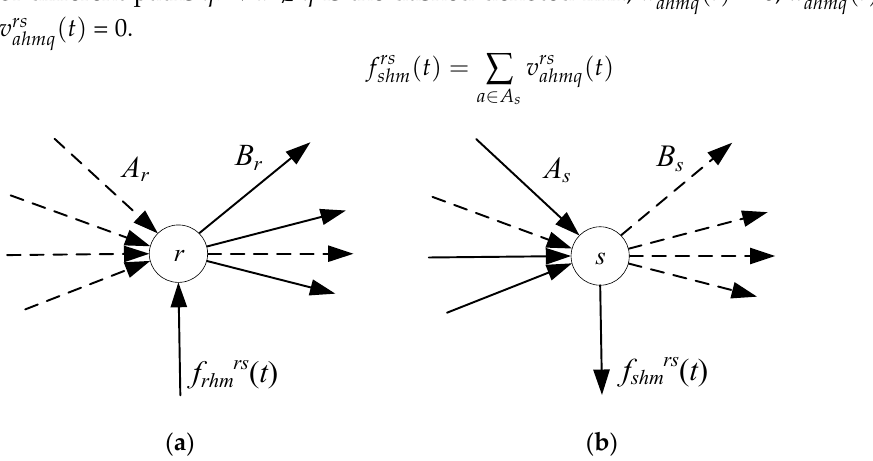
Figure 3. ( a ) Flow conservation constraints (FCC) at origin r of vehicle m in task h ; ( b ) FCC at destination s of vehicle m at task h .